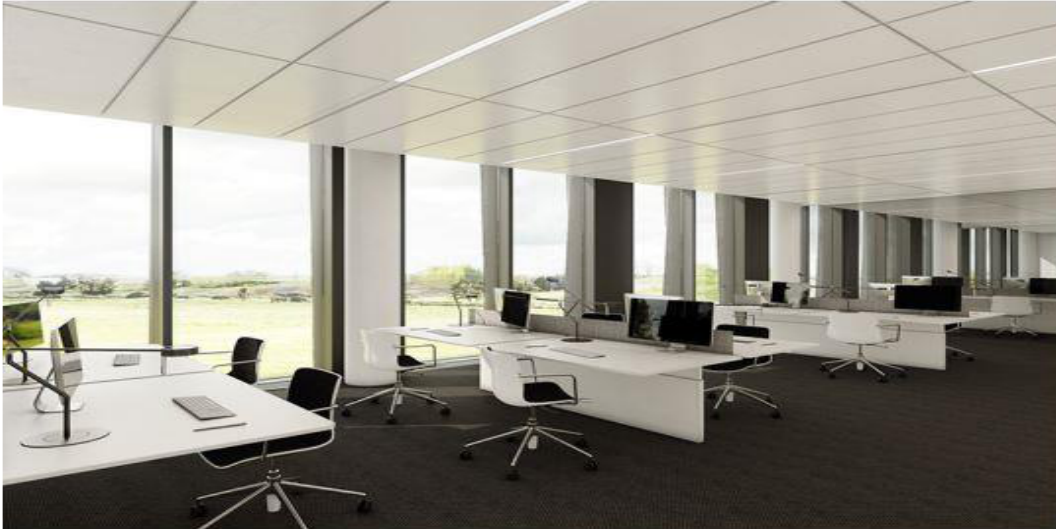
Figure 4. Nordea Bank Headquarters: Interior view showing visual transparency of the facade. [Source: Henning Larsen Architects]